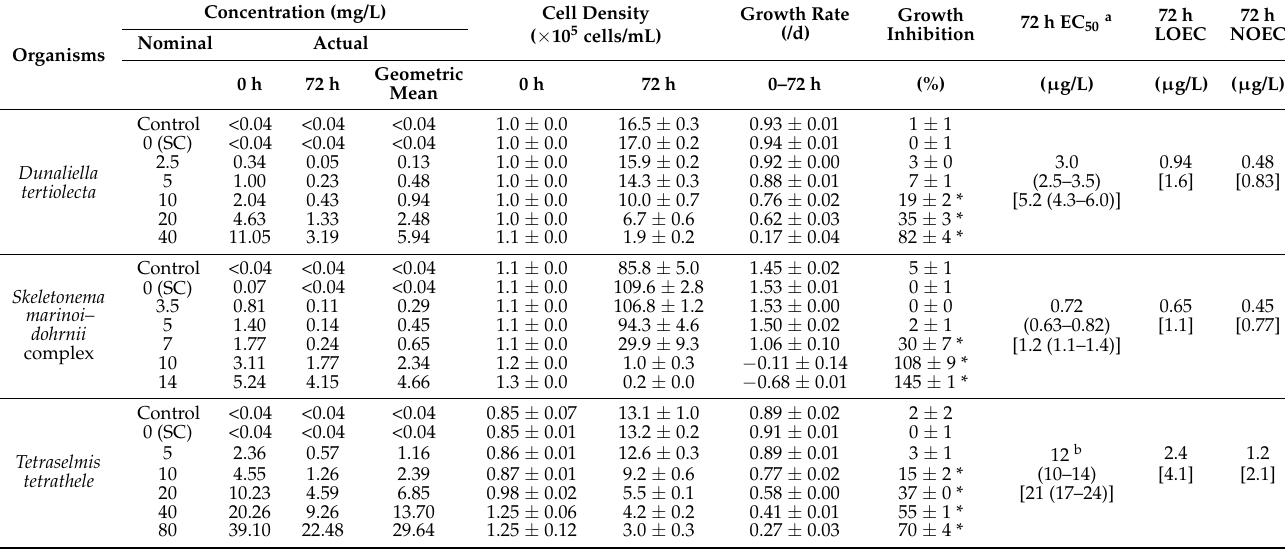
Data are expressed as the mean ± standard error. * Significantly different ( p < 0.05) from the value for the solvent control. a : The 95% confidence intervals are given in parentheses. b : This value was considered the reference value because growth rate in the control was lower than 0.92/day. SC: solvent control; EC 50 : 50% effective